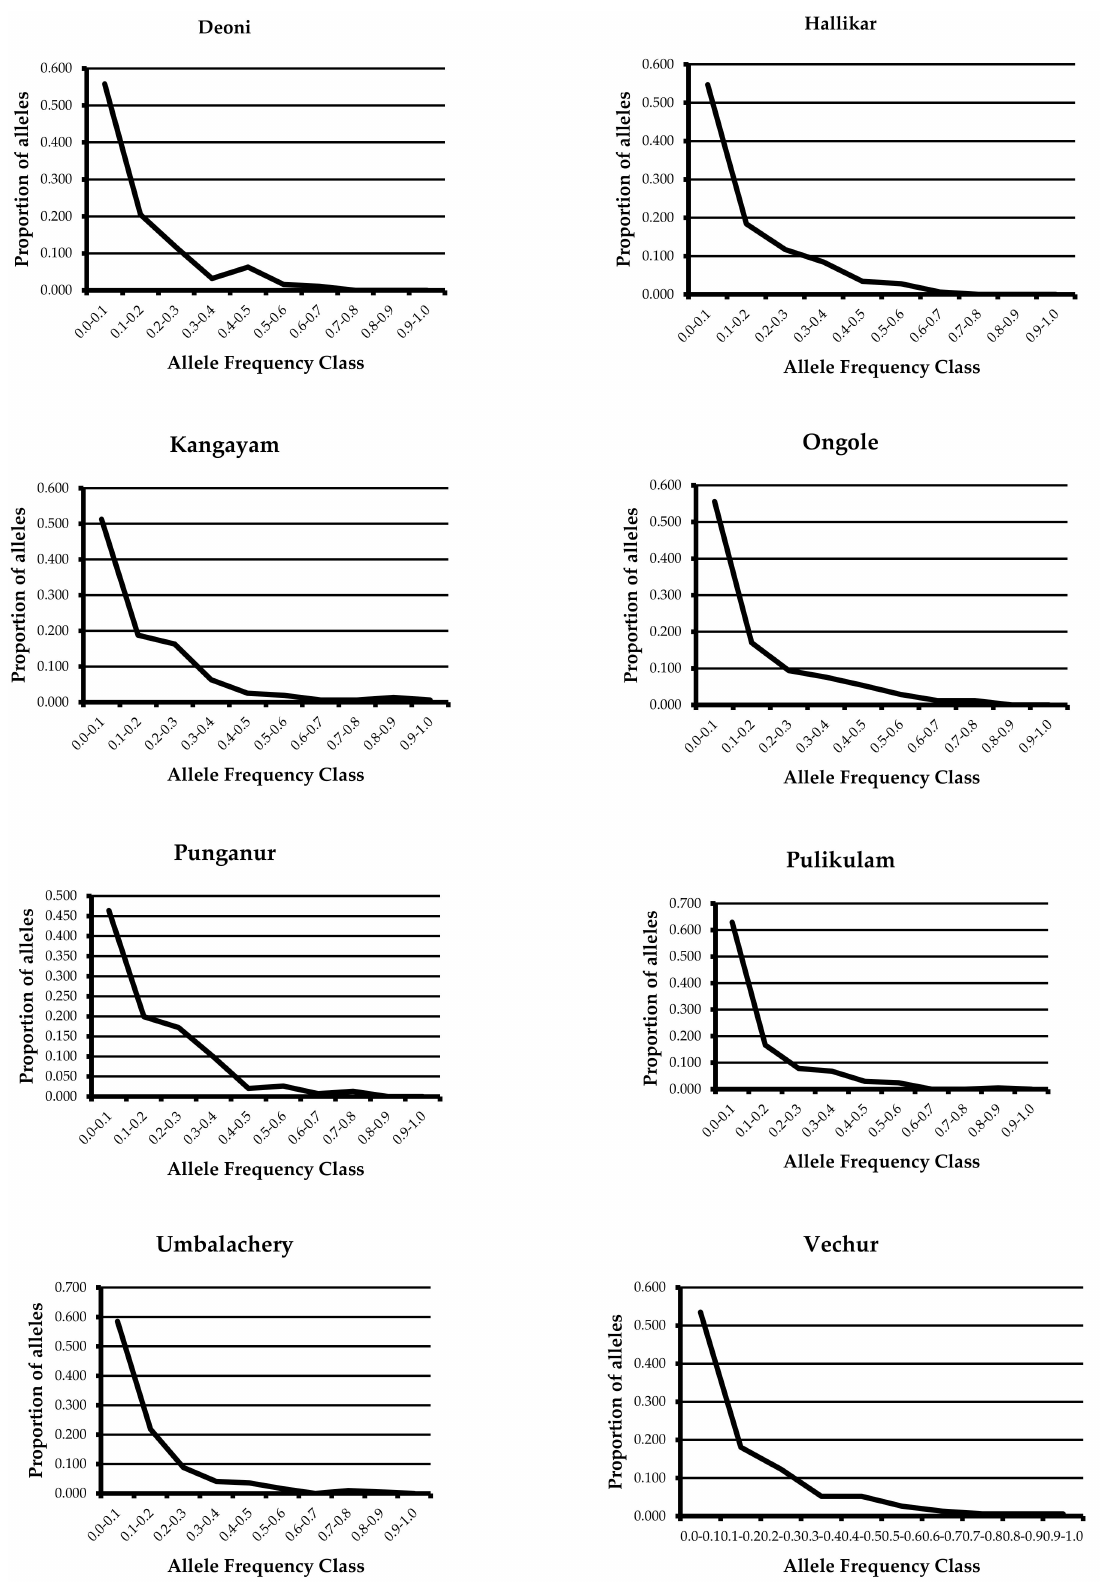
Figure 1. Qualitative test of mode shift for the detection of recent genetic bottlenecks in South Indian Zebu cattle